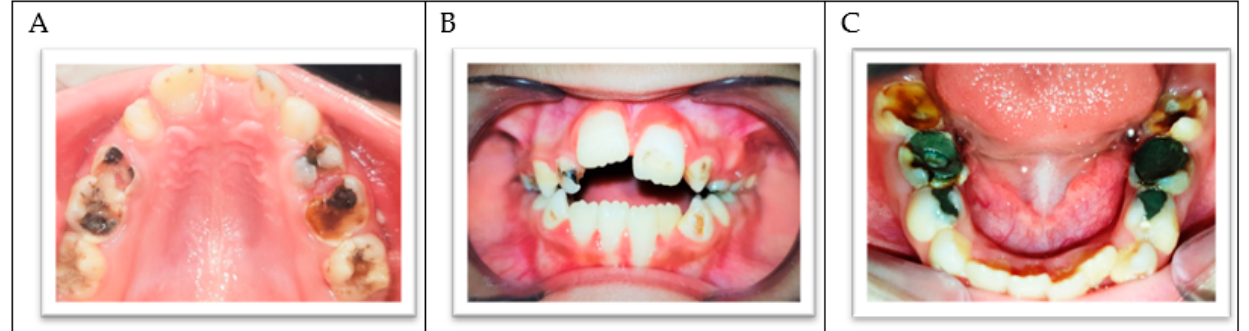
Figure 2. ( A ) The upper arch. ( B ) Frontal view of both arches in occlusion. ( C ) The lower arch. bud, multiple carious teeth, and apical lesions affecting multiple teeth, including the lower permanent first molars (Figure 3).